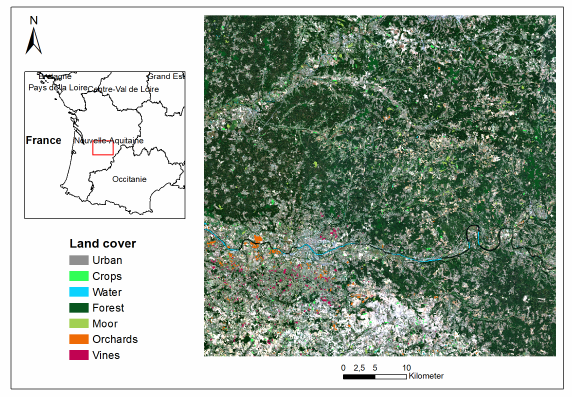
Figure 1. Location of the Dordogne study site.